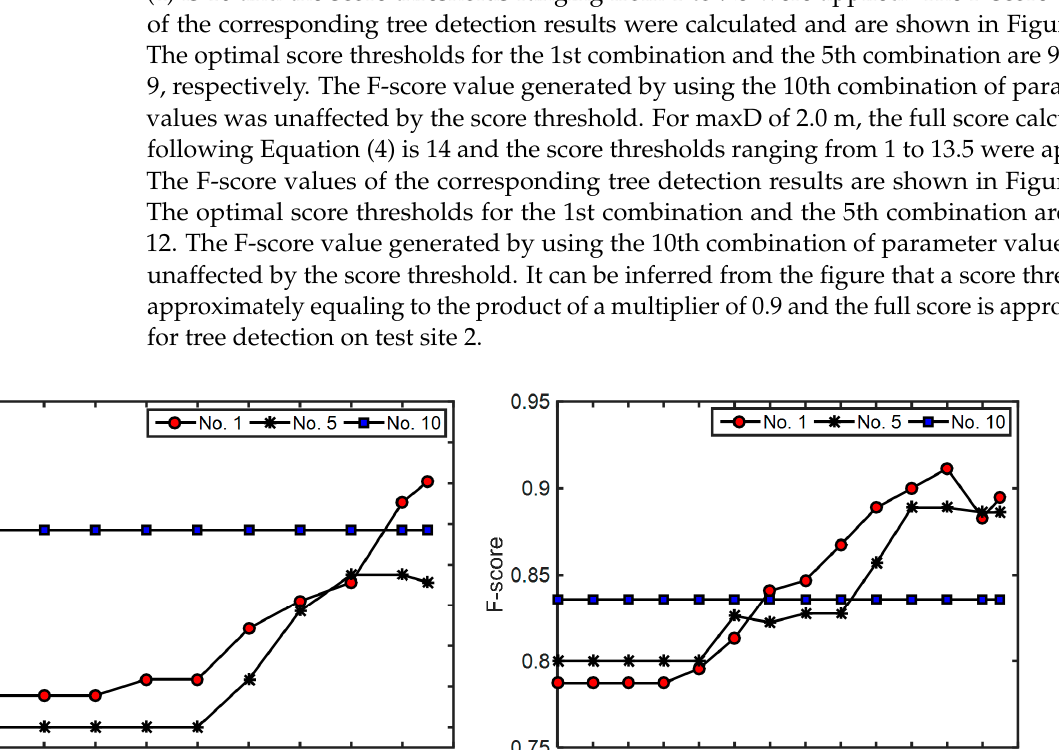
Figure 15. The effects caused by changing significance level on test site 2. Recall (F-score) differ-